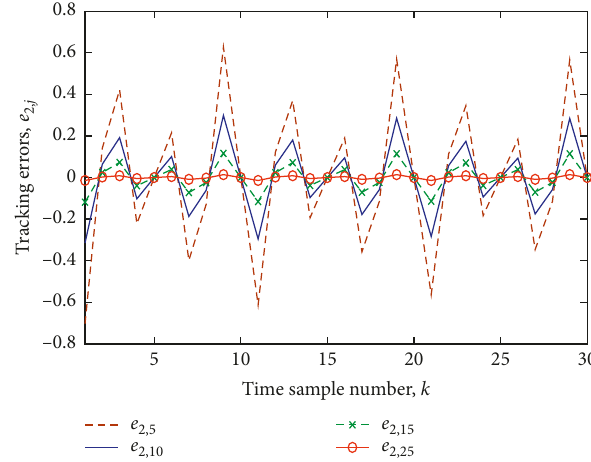
Figure 5: Initial tracking errors e number j .